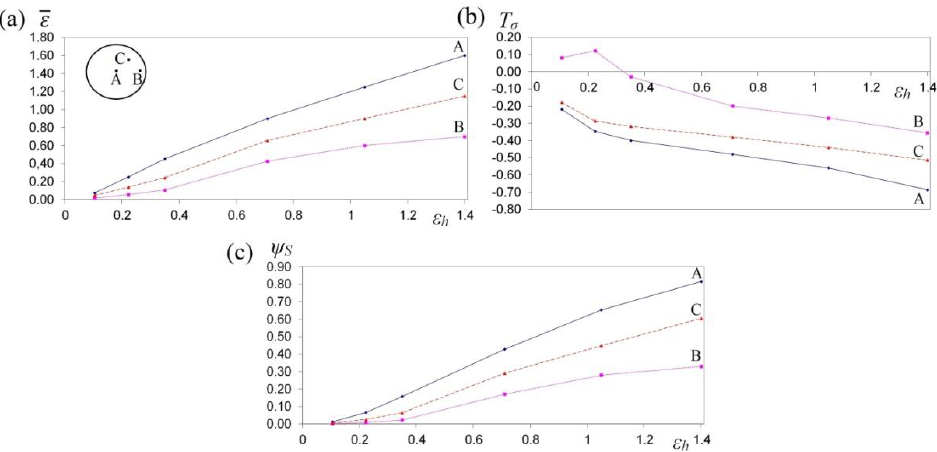
Figure 15. The variation in e ff ective strain ε ( a ), stress triaxiality T σ ( b ) and the deformation damage factor Ψ S ( c ) at selected points A, B and C during the cogging process of X32CrMoV12-28 die steel specimens in anvils with skew working surfaces.